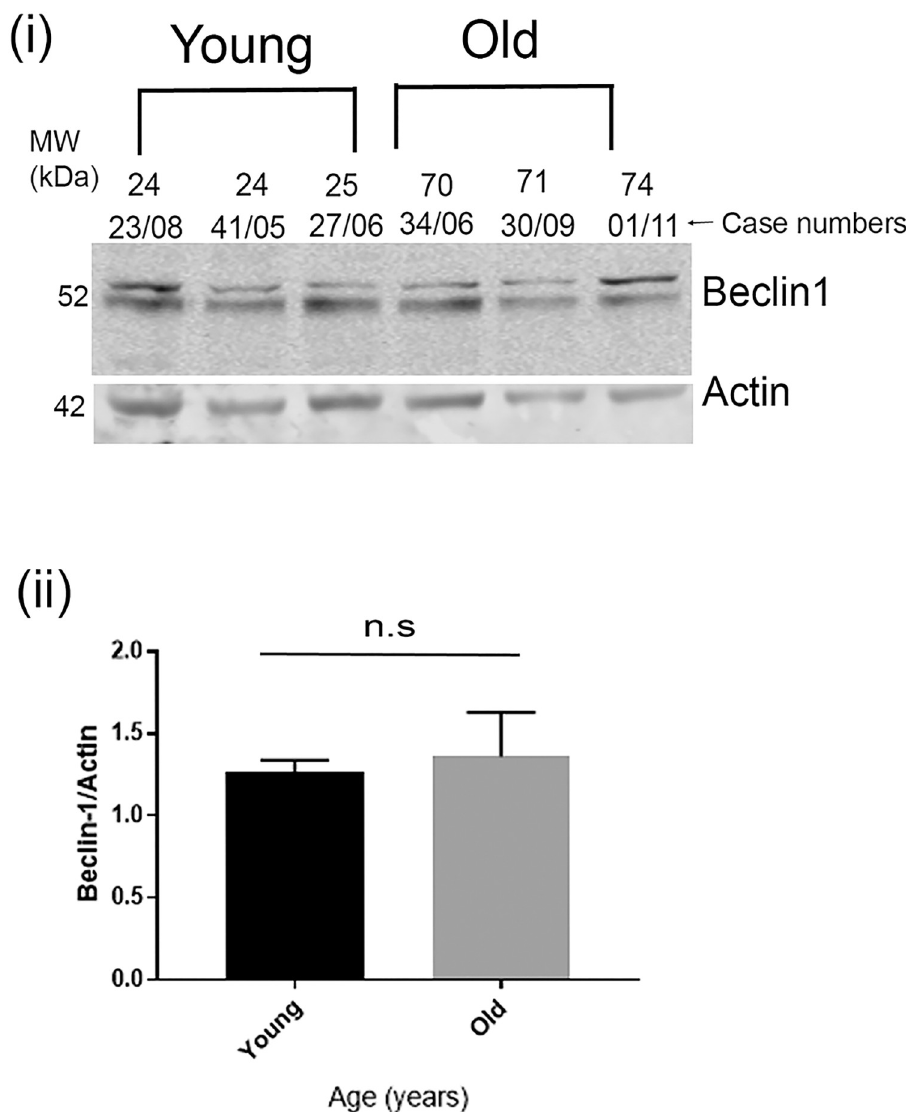
and quantification of Beclin 1 normalized to Actin (ii). In post-mortem samples n = 7 (older brains), n = 6 (younger brains). p values are not significant by two-tailed unpaired t test. Data represent mean ±